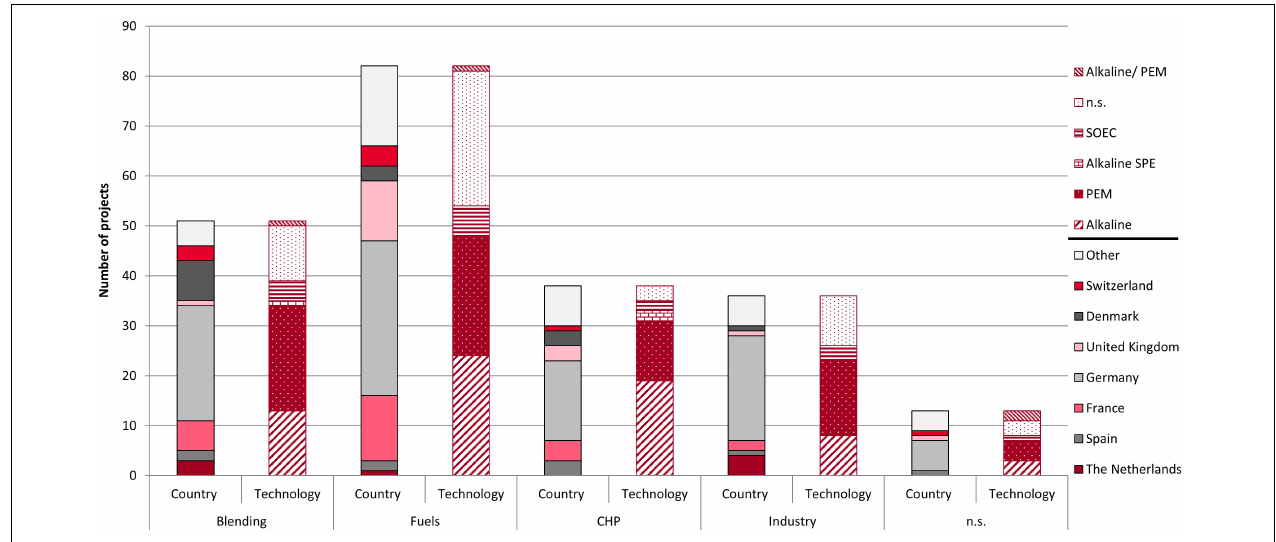
FIGURE 9 | Fields of application for Power-to-X projects according to countries and technologies. PEM. polymer electrolyte membrane; SOEC, solid oxide electrolyzer cell; SPE, solid polymeric electrolyte.